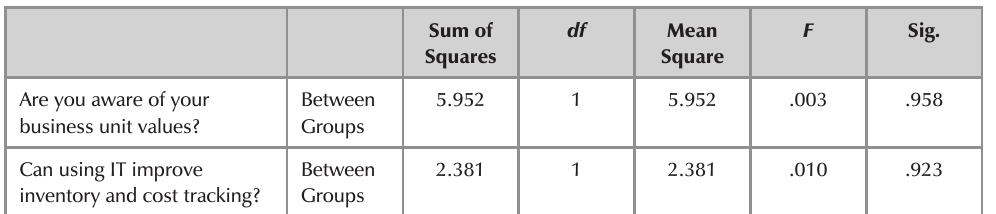
ANOVA by business unit